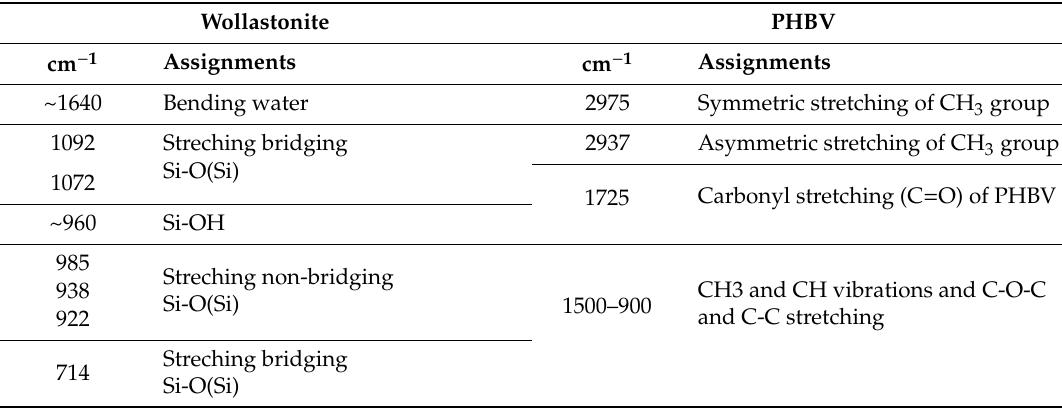
Table 2. The FTIR active vibrational modes of the WOL and PHBV.